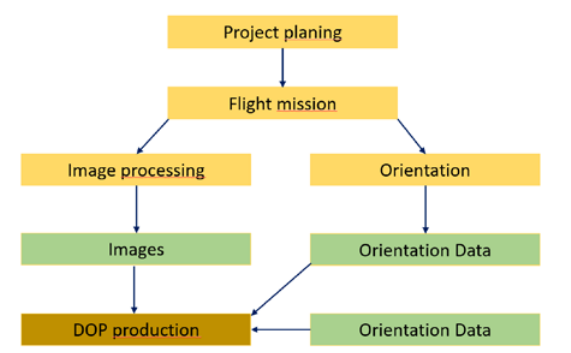
Fig. 2: Process steps complete DOP process